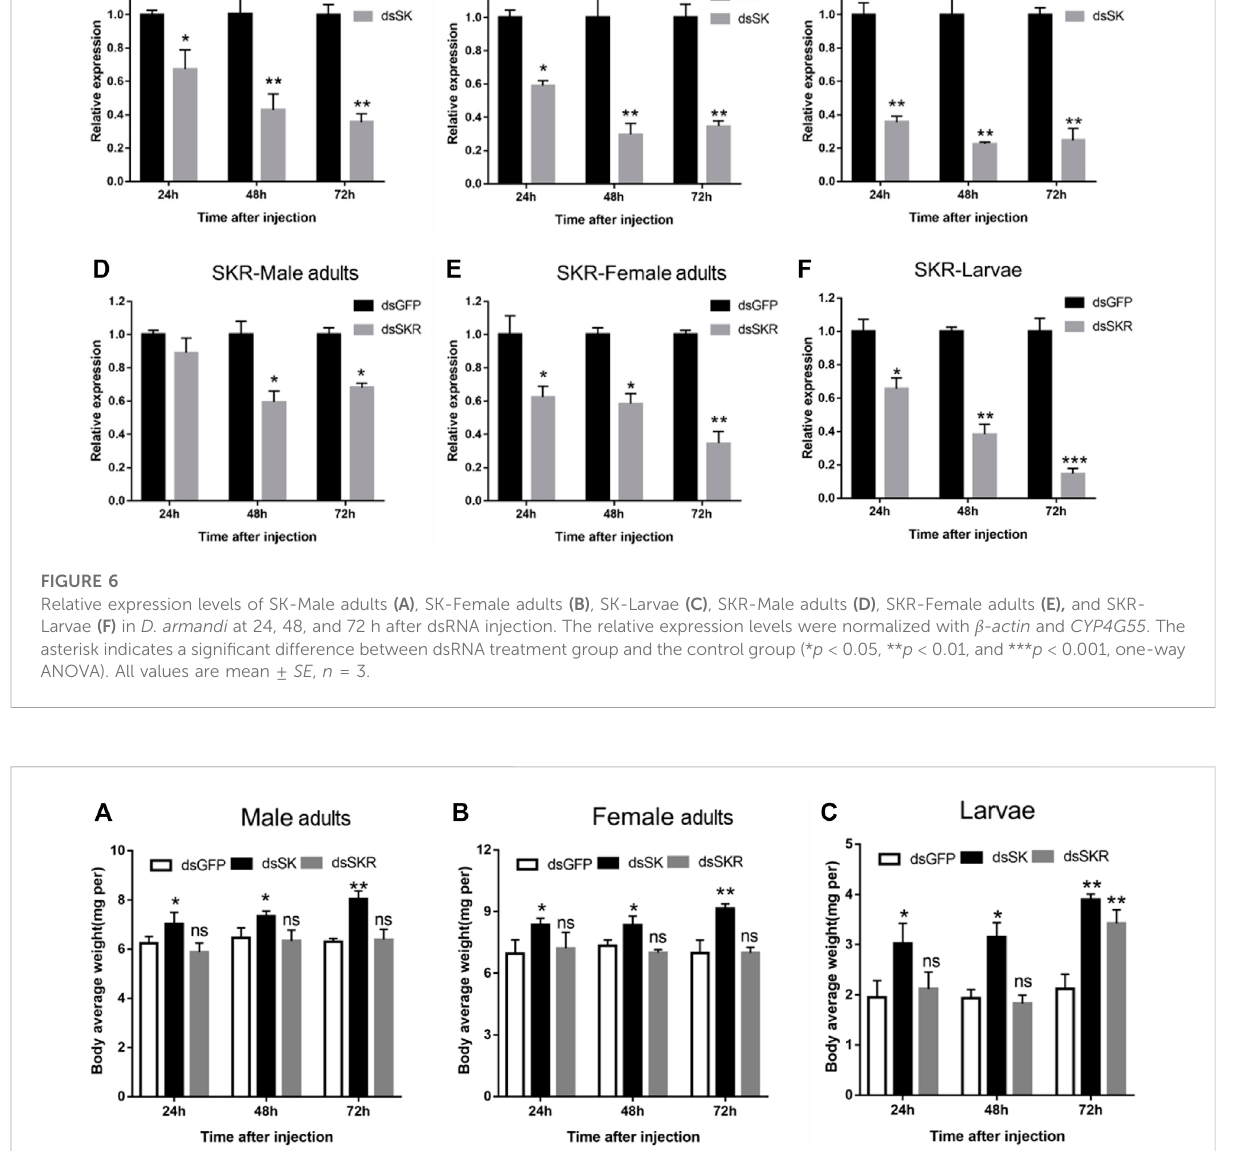
FIGURE 7 EffectofdsSKanddsSKRonbodyaverageweightofmaleadults (A) ,femaleadults (B) ,andlarvae (C) .Sampleswerecollectedandassayedat24, 48, and 72 h after injection. The asterisk indicates a signi fi cant difference between treatments (* p < 0.05 and ** p < 0.01, ns, not signi fi cant, one-way ANOVA). All values are mean ± SE , n =